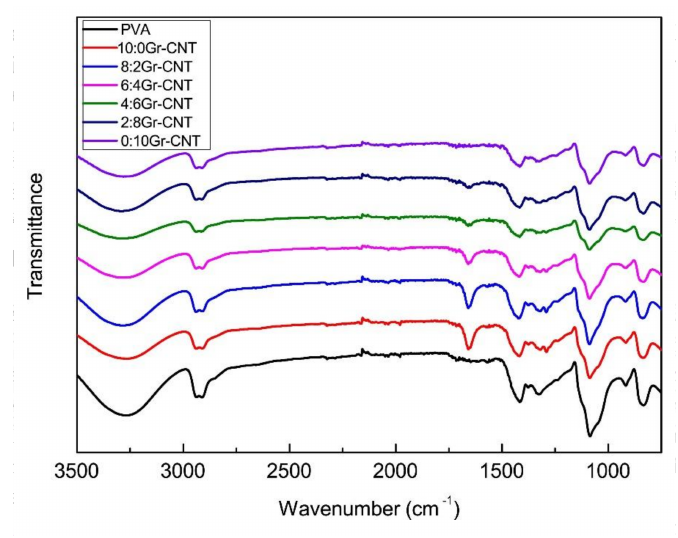
Figure 4. FTIR spectrum of PVA / SA / Gr / CNT nanofibrous membranes as related to Gr-CNT ratios.